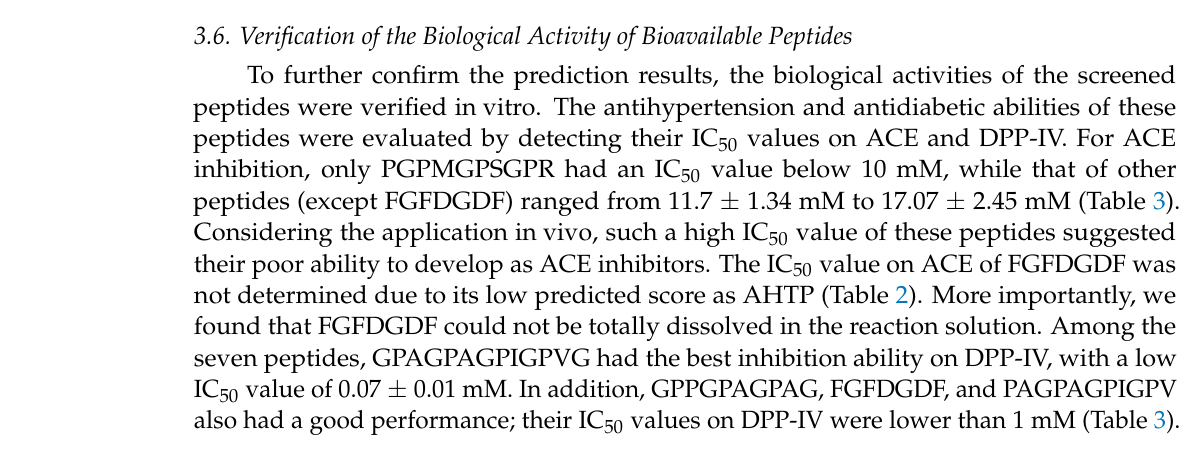
Table 3. The IC 50 values on ACE and DPP-IV of the seven screened bioavailable